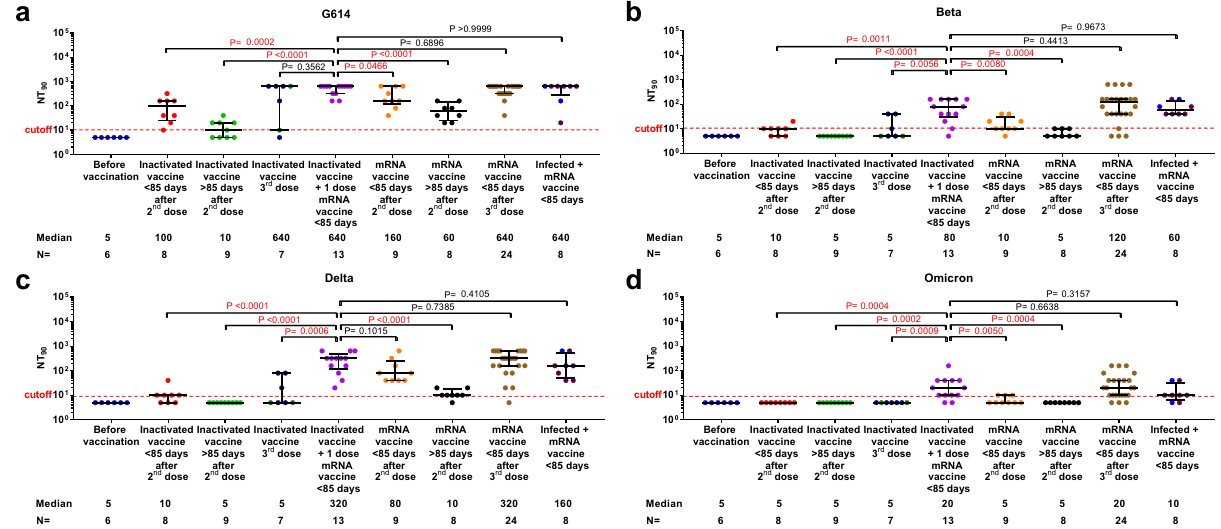
Fig. 2 Plasma neutralization activity against SARS-CoV-2 in different vaccination groups. Plasma neutralizing titers against Beta, Delta and Omicron variants of concern compared to the G614 virus ( a – d ). The fi gure shows the comparisons of 90% neutralizing titer (NT90) values in samples collected before vaccination and after different types of vaccinations. Symbols represent individual subjects and horizontal black lines indicate the median. For each group, the number of samples ( N = ) and median antibody titers are shown below the X -axis. The dashed red line indicates the titer cutoff-value ( ≥ 1:10). The inactivated vaccine 3rd dose group was color-coded based on <85 days (dark blue) or >85 days (green). In the last group, convalescent donors (prior history of infection) were color-coded based on receiving one (purple) or two doses (blue) of mRNA vaccine. Whiskers indicate the interquartile range. Two-sided Mann – Whitney U test was used and P < 0.05 was considered statistically signi fi cant and marked with red color.